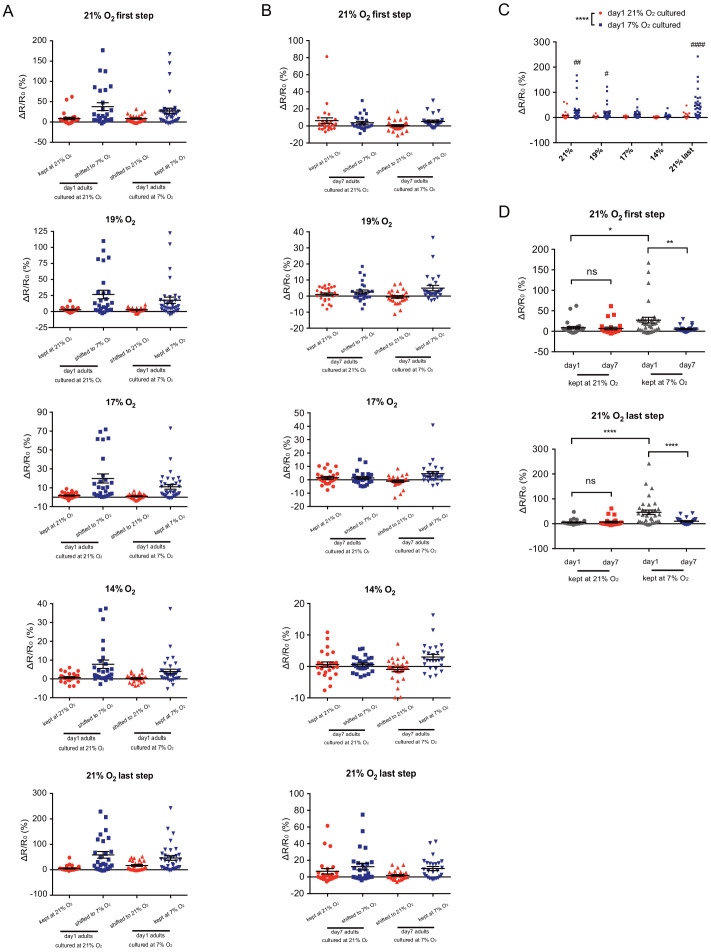
Scatter plots showing URX Ca2+ responses of day 1 and day 7 adults cultured at 21% or 7% O2.(A–B) Scatter plots of URX Ca2+ responses of day 1 (A) and day 7 (B) adults at 21%, 19%, 17%, 14% O2 and after the upstep back to 21%O2. (CE) URX of 7% O2 cultured animals displays elevated [Ca2+] to high (21%) and intermediate (19%, 17%, 14%) O2 compared to 21% O2 cultured animals. ****p<0.00015 indicates a significant effect of O2 culture condition on Ca2+ responses, #p<0.5, ##p<0.01, ####p<0.0001 indicates a significant difference of Ca2+ response at that O2 concentration, mixed model ANOVA with Holm-Sidak test. (DF) URX Ca2+ responses to the initial and final (21%) O2 stimulus steps are increased in 1-day-old 7% O2 cultured animals relative to those of 21% O2 cultured animals, and decline with age only in the 7% O2 cultured animals. *p<0.05, **p<0.01, ****p<0.0001, ns, p>0.05, one-way ANOVA with Holm-Sidak test.